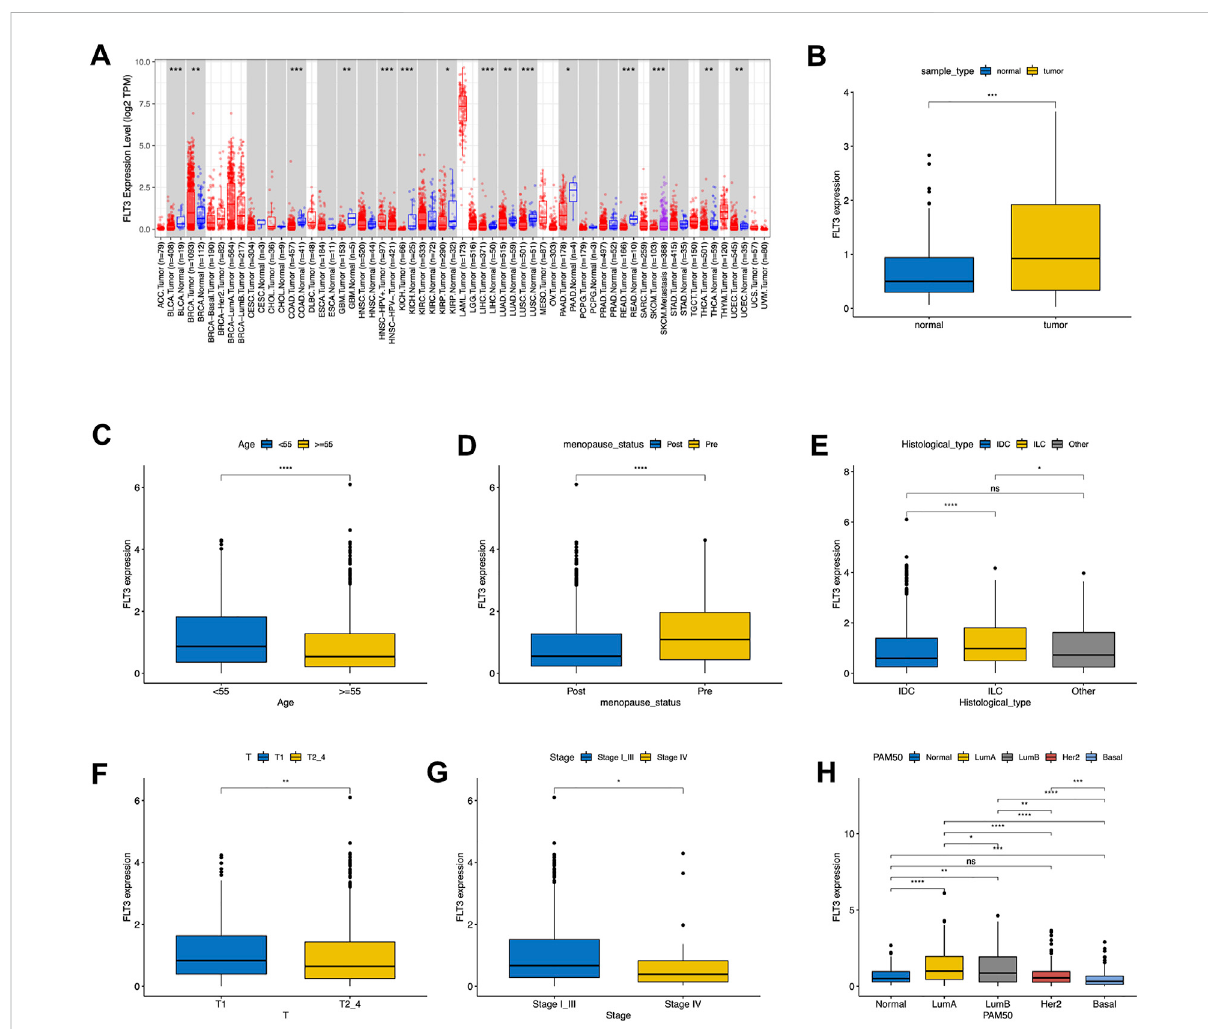
FIGURE 1 Associations between FLT3 expression and clinical – pathological variables in BC. The level of FLT3 expression in different tumor types from TCGA data analyzed in TIMER. FLT3 was highly expressed in breast cancer (BRCA), and lowly expressed in bladder cancer (BLCA), cervical cancer (CECS), bile duct cancer (CHOL), colon adenocarcinoma (COAD), head and neck cancer (HNSC) tissue, kidney chromophobe (KICH), kidney clear cell carcinoma (KIRC), Liver hepatocellular carcinoma (LIHC), lung adenoma (LUAD), lung squamous cell carcinoma (LUSC), pancreatic adenocarcinoma melanoma (PAAD), pheochromocytoma and paraganglioma (PCPG), prostate adenocarcinoma (PRAD), rectum adenocarcinoma (READ),stomachadenocarcinoma(STAD),thyroidcancer(THCA)andendometrioidcancer(UCEC)and (A) .HighexpressionofFLT3wasobservedin tumor tissue both in all samples (B) . FLT3 expression was analyzed in female and male (C) , postmenopausal and premenopausal (D) patients, with differenthistologicaltypes (E) ,includinginvasiveductalcarcinoma(IDC),invasivelobularcarcinoma(ILC),andallotherspeci fi ctypes,differenttumor size (F) (T1 versusT2, T3, and T4), different pathological TNM stage (G) (Stage I, II and III versus Stage IV) and different PAM50 molecular subtypes (H) , T1, tumor ≤ 20 mm in greatest dimension; T2, Tumor > 20 mm but ≤ 50 mm in greatest dimension; T3, Tumor > 50 mm in greatest dimension; T4, Tumor of any size with direct extension to the chest wall or the skin (ulceration or macroscopic nodules); invasion of the dermis alone does not qualify asT4;N0,no regionallymphnodemetastasis;N1,metastasis in1 – 3axillary lymphnodes;N2,metastasis in4 – 9axillary lymphnodes;andN3, metastasis in 10 or more axillary lymphnodes; M0, without distant metastasis; and M1, with distant metastasis; Stage I, T1N0M0; Stage II, T0-1N1M0, T2N0-1M0, T3N0M0; StageIII,anyTstagewith N2M0orN3M0,T4N0M0,T3-4N1M0;StageIV,anyTorNstagewithM1. Theasterisks representthe statistical p -value (ns: p > 0.05, * p ≤ 0.05, ** p ≤ 0.01, *** p ≤ 0.001, **** p ≤